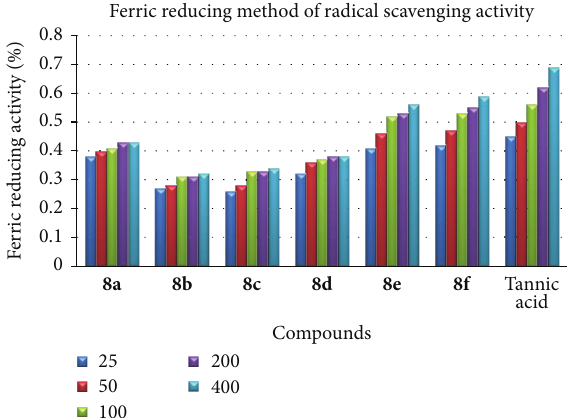
Figure 2: Ferric reducing Method of radical scavenging